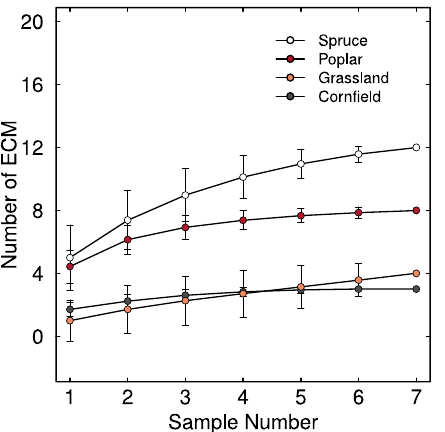
Figure 1. Species accumulation curves for ECM fungal species in poplar root tips on the four investigated former land use type.